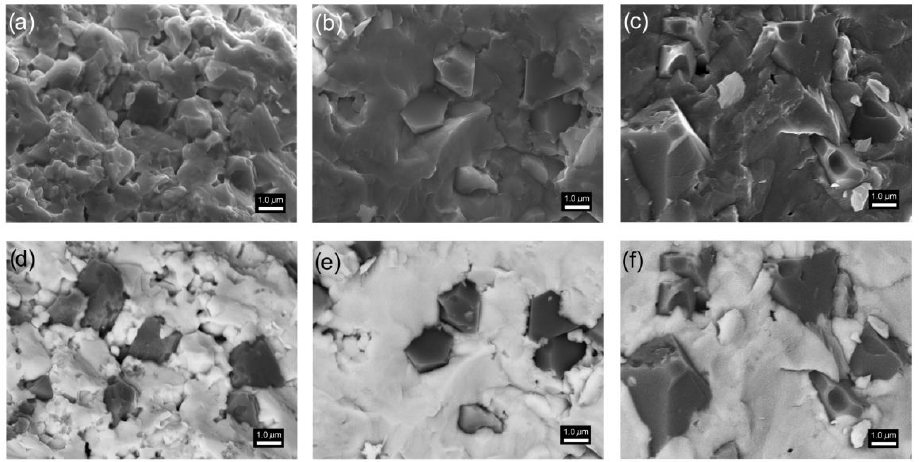
Figure 3. SEM images of the PF multiferroic composites: ( a , d ) PF-SPS, ( b , e ) PF-HP, and ( c , f ) PF-FS, made using the standard SB method ( a – c ) and BSE method ( d – f